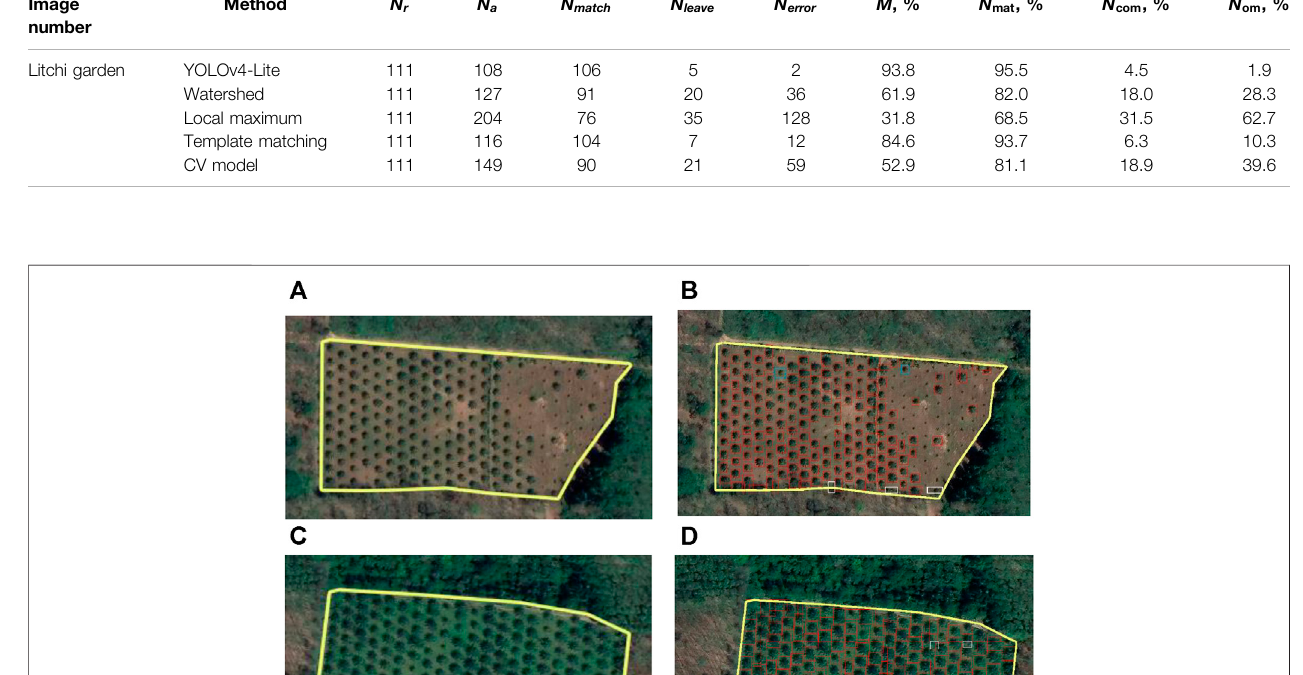
Frontiers in Environmental Science |